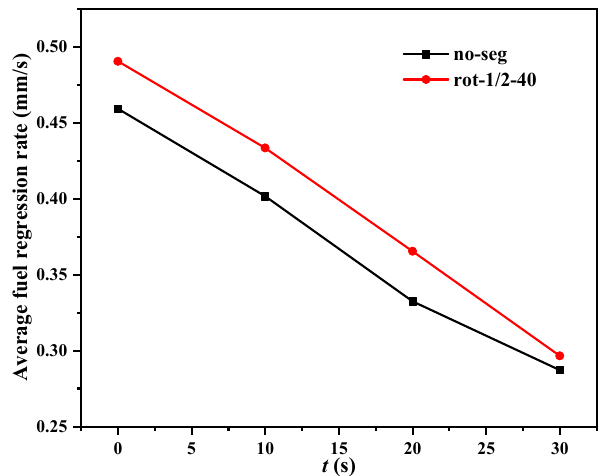
Figure 34. Average fuel regression rates at different times.